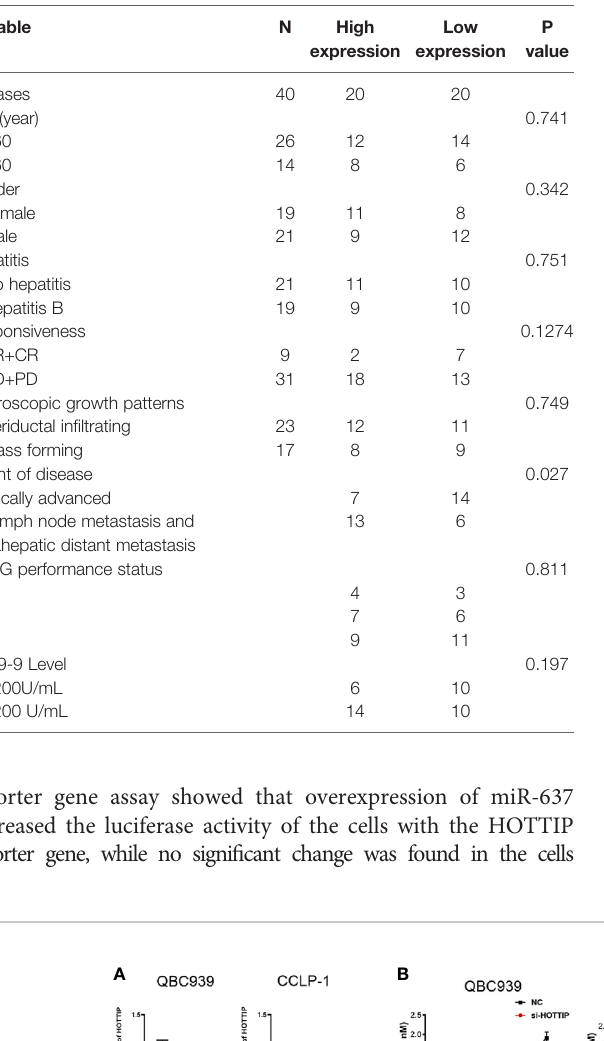
TABLE 1 | HOTTIP expression in CCA patients.